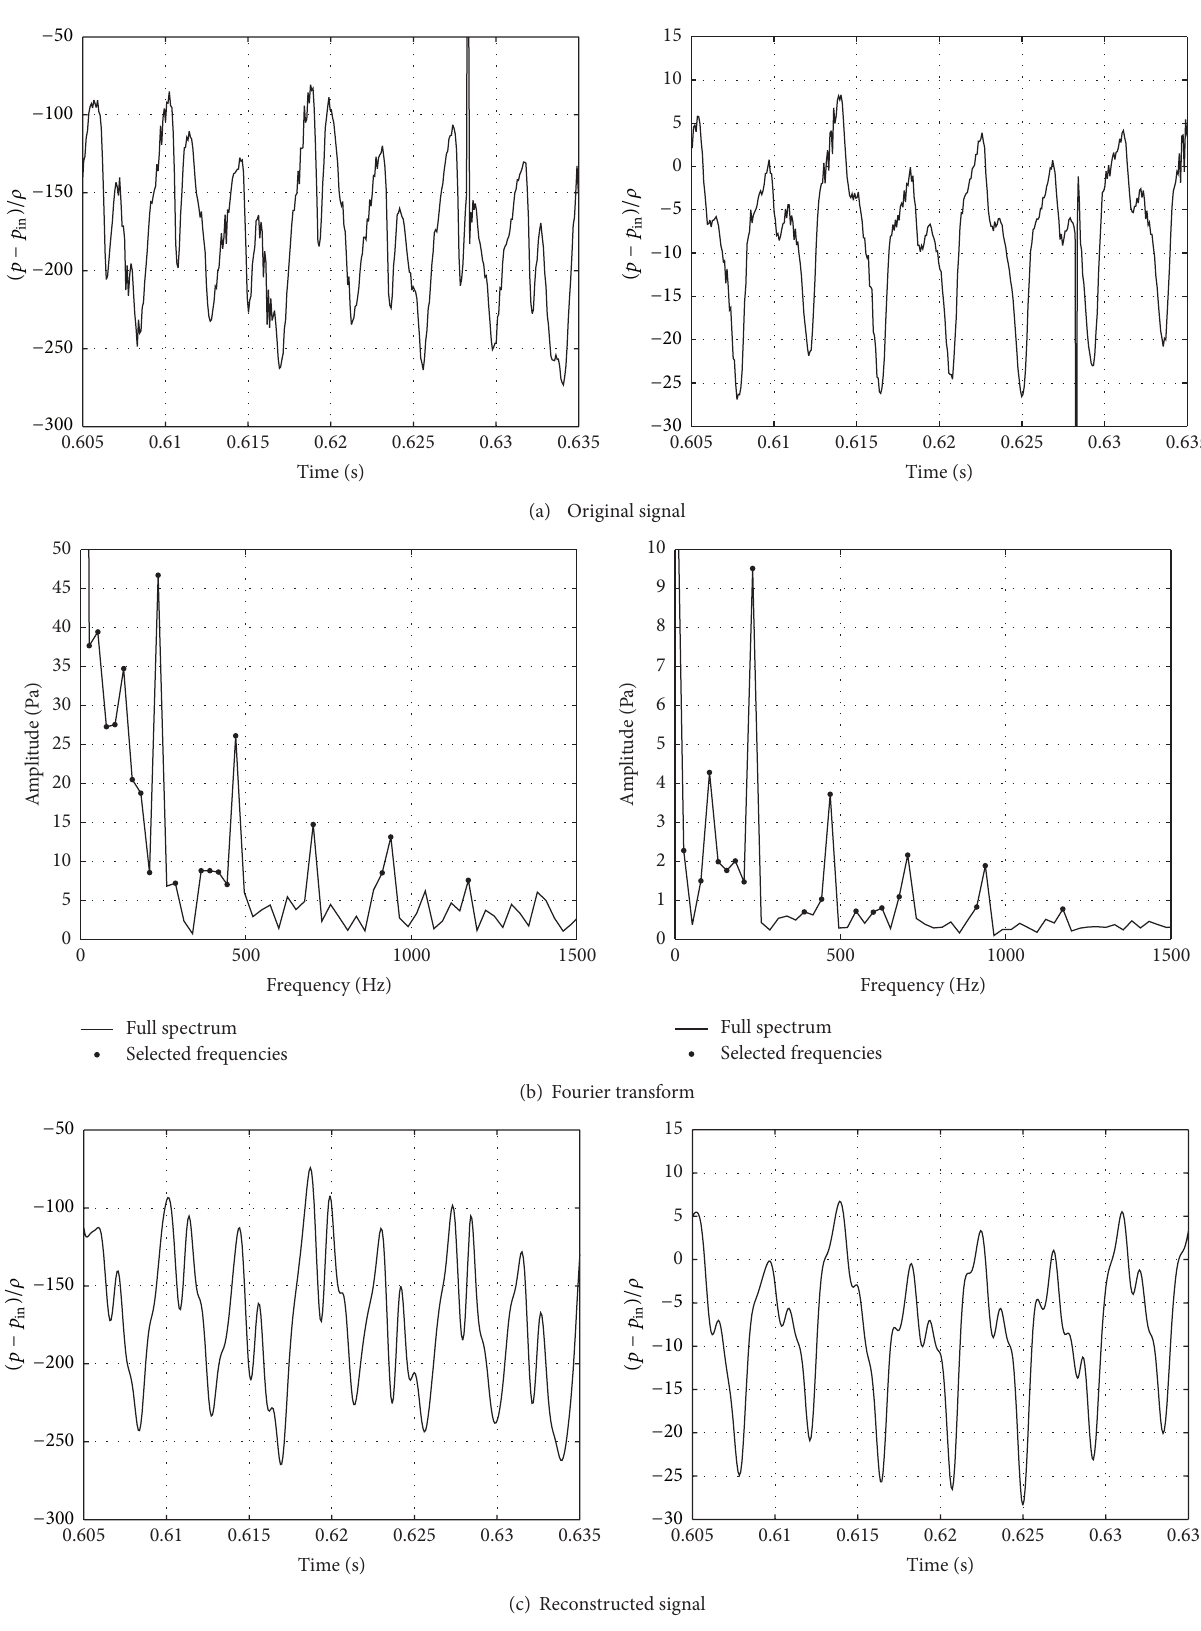
Figure 11: Pressure signal for the probe located at the outlet of the impeller (left) and at the outlet of the diffuser (right). The signal in (c) is reconstructed using the 20 main frequencies selected in